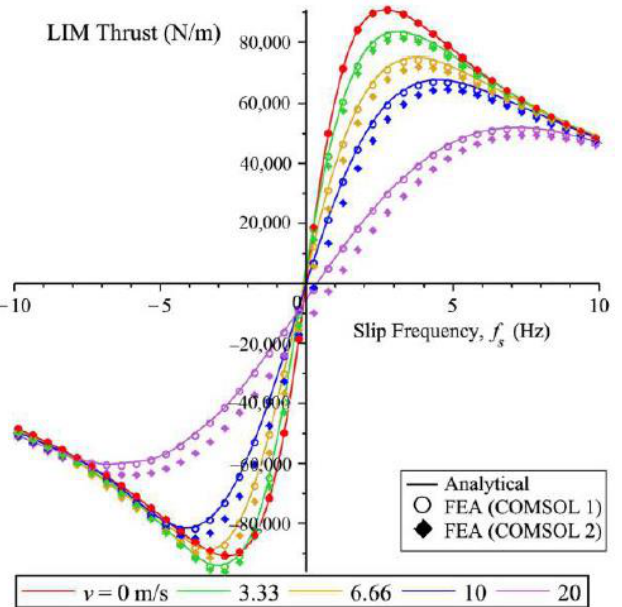
Figure 8. Average thrust per unit depth versus slip frequency for a LIM from Figure 7 [62].